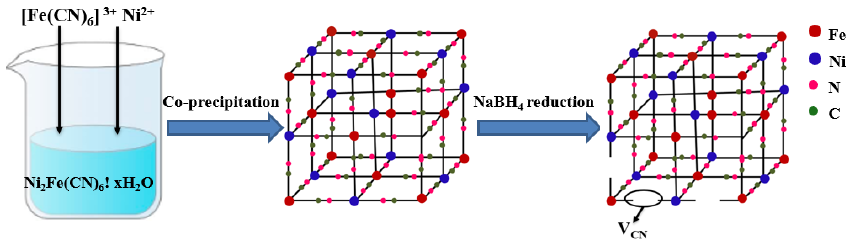
Figure 1. The schematic illustration of the synthetic process of D-NiFe PBA.